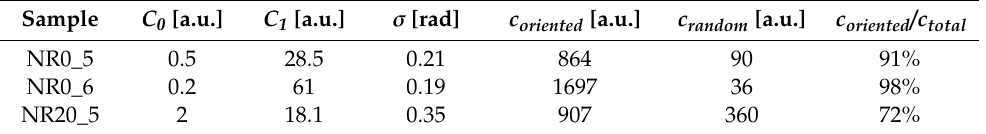
Table 1. Parameters of the orientation distribution of the a-axis of crystallites in the di ff erent NR-samples. C 0 and C 1 and so c oriented and c random are estimated for the measurements and not normalized.